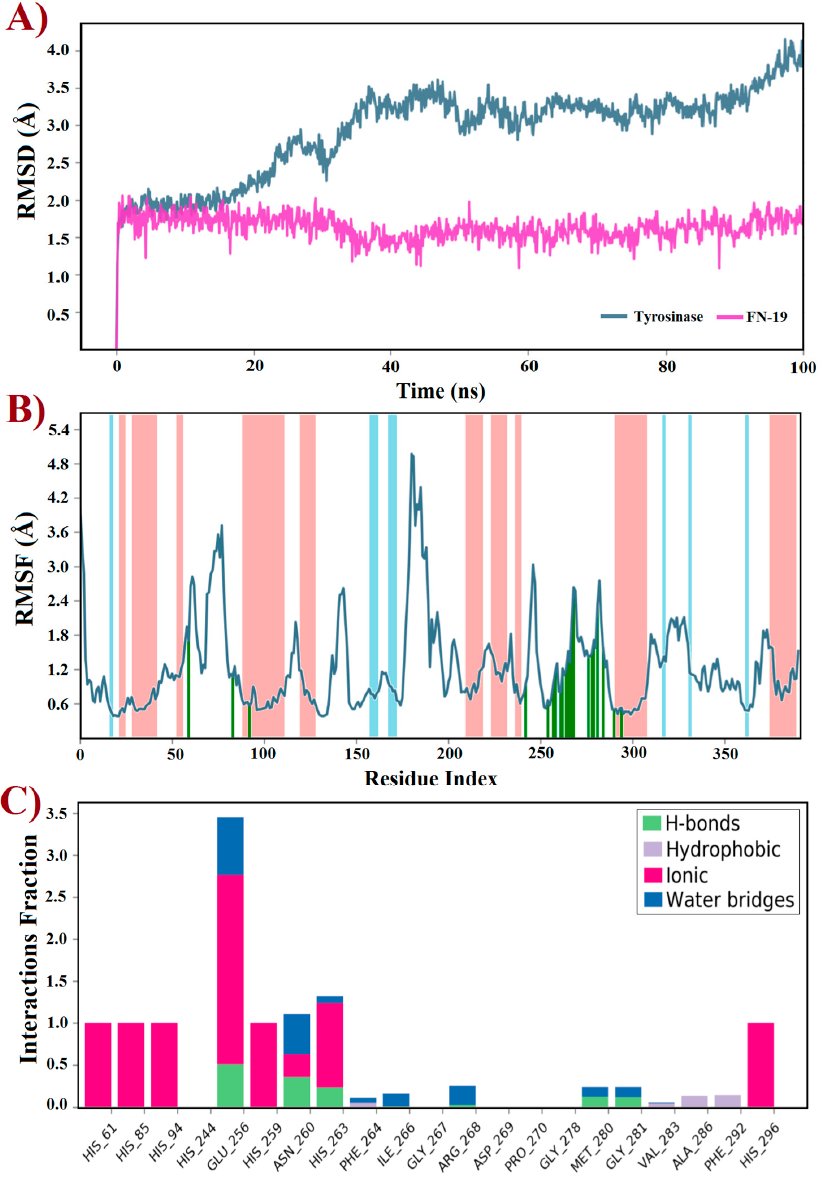
Figure 4. Trajectories for ( A ) RMSD, ( B ) RMSF, and ( C ) interactions fraction obtained using molecular dynamics simulations within 100 ns at 300 K of tyrosinase (PDB id: 2Y9X) complexed with the FN-19 inhibitor. In B, red zones mean alpha-helixes, whereas the beta-sheets are colored in blue; finally, the ligand interactions are shown in green lines.